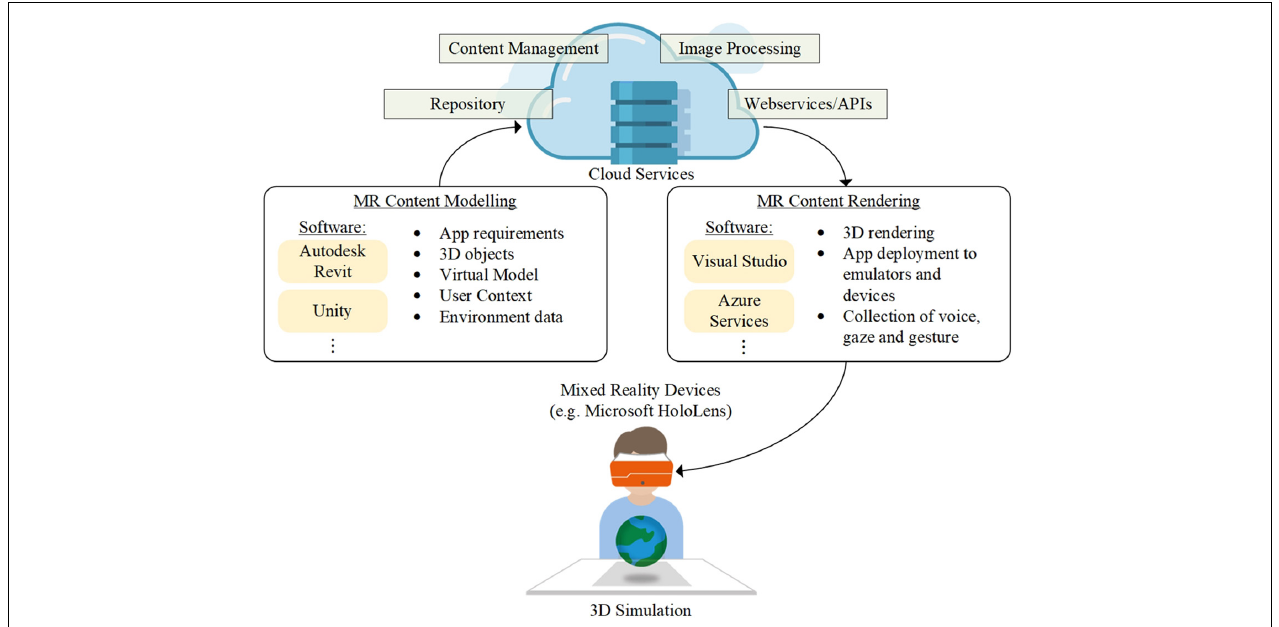
FIGURE 1 | Architecture of mixed reality (MR)-based Technology